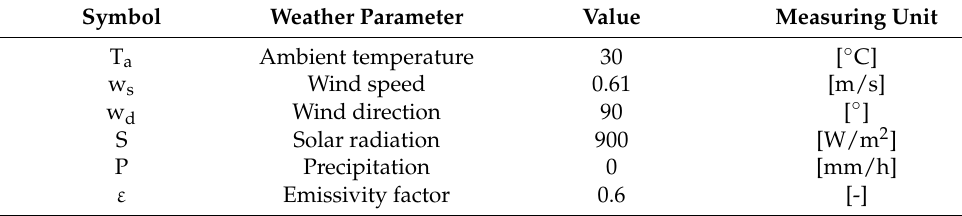
Table 6. Weather parameters for static line rating 1 .